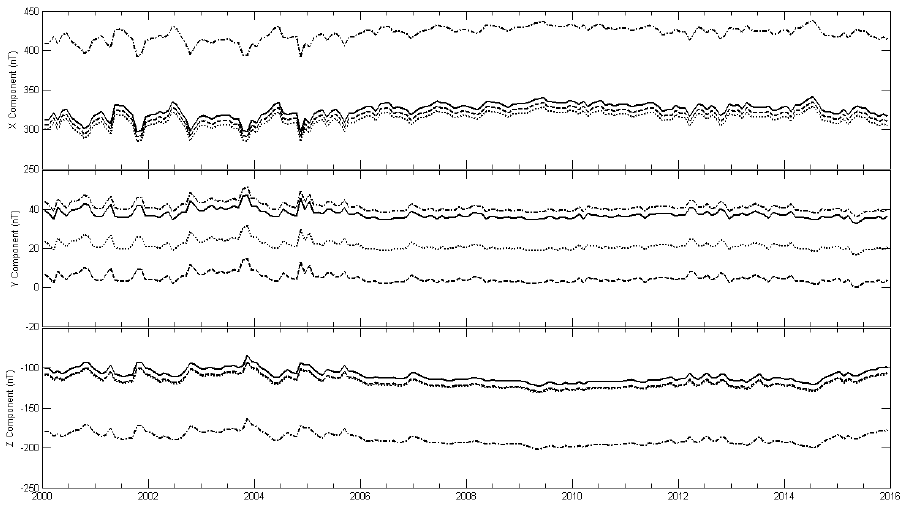
Figure 7. X, Y, Z - component differences between monthly mean values at NGK observatory and respective values predicted by CM5 model with maximum degrees L : a) 100 (dash-dotted line), b) 85 (solid line), c) 60 (dotted line), d) 40 (dashed